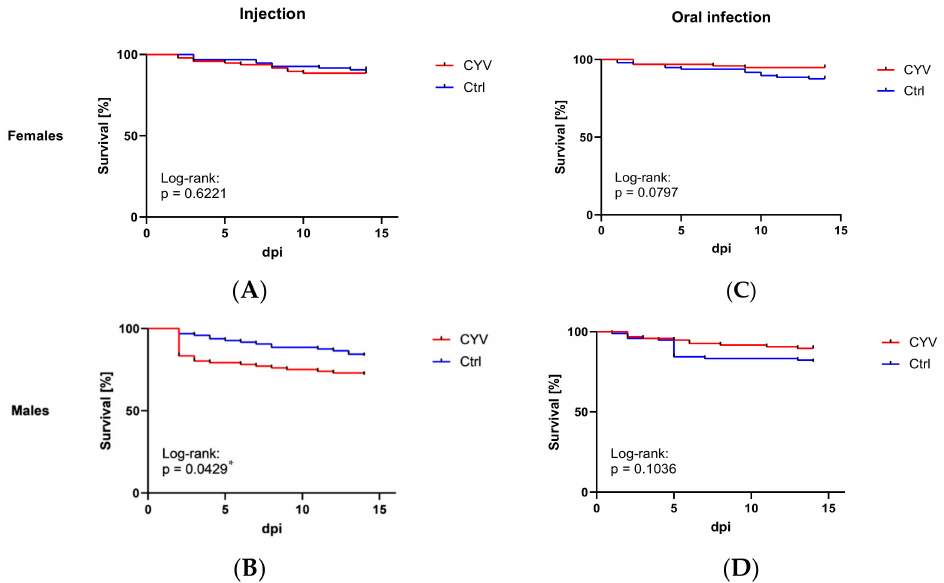
Figure 5. Survival curves of infected Cx. pipiens biotype molestus mosquitoes comparing CYV- infected and control mosquitoes per sex and infection route. The data represent the survival rates in percentages over days post-infection (dpi). ( A ) CYV-injected females vs. medium-injected females; Log-rank: p = 0.6221 (ns). ( B ) CYV-injected males vs. medium-injected males; Log-rank: p = 0.0429 (*). ( C ) CYV-fed males vs. medium-fed males; Log-rank: p = 0.1036 (ns). ( D ) CYV-fed females vs. medium- fed females; Log-rank: p = 0.0797 (ns). Red curve—CYV-infected mosquitoes; blue curve—control (Ctrl) mosquitoes.